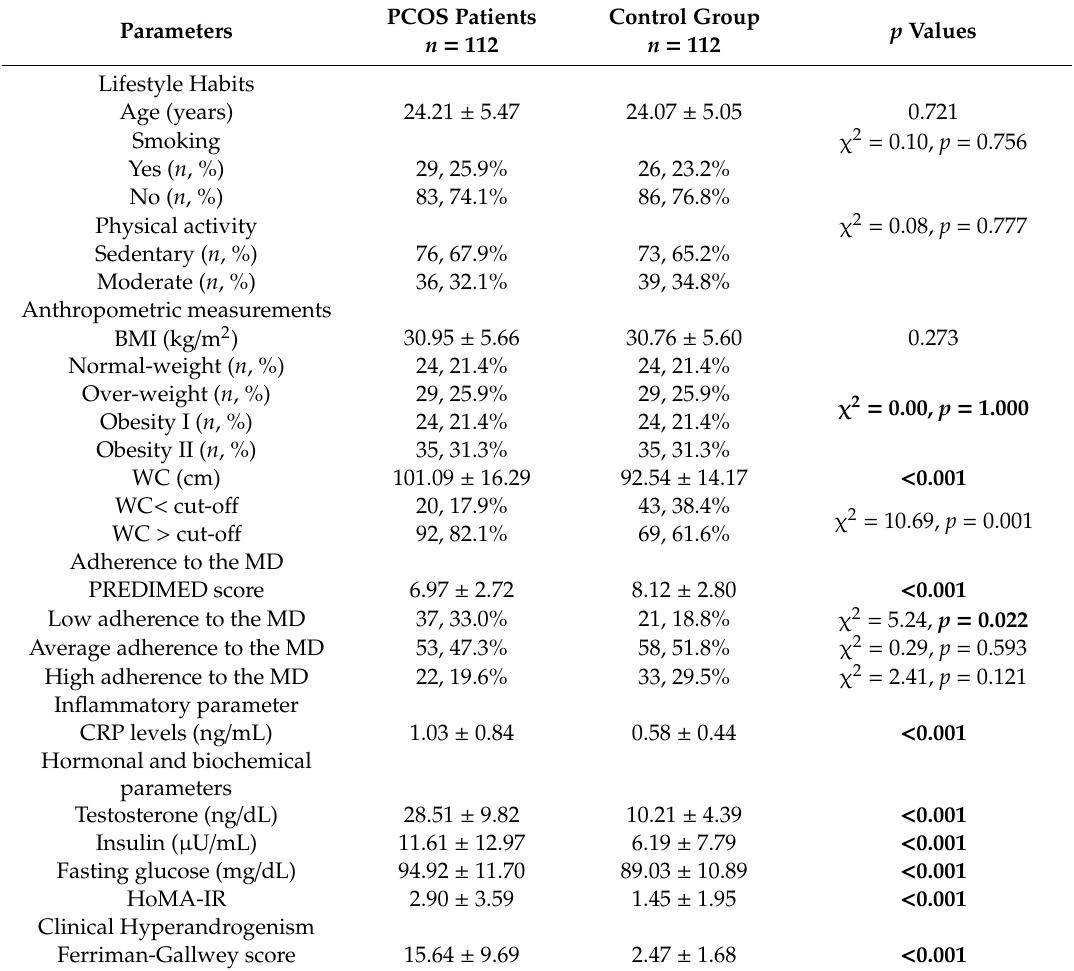
Table 1. Lifestyle habits, anthropometric measurements, adherence to the Mediterranean diet (MD), inflammatory parameter, hormonal, and biochemical parameters and clinical hyperandrogenism of the case-patients and the subjects matched for age and BMI, serving as control